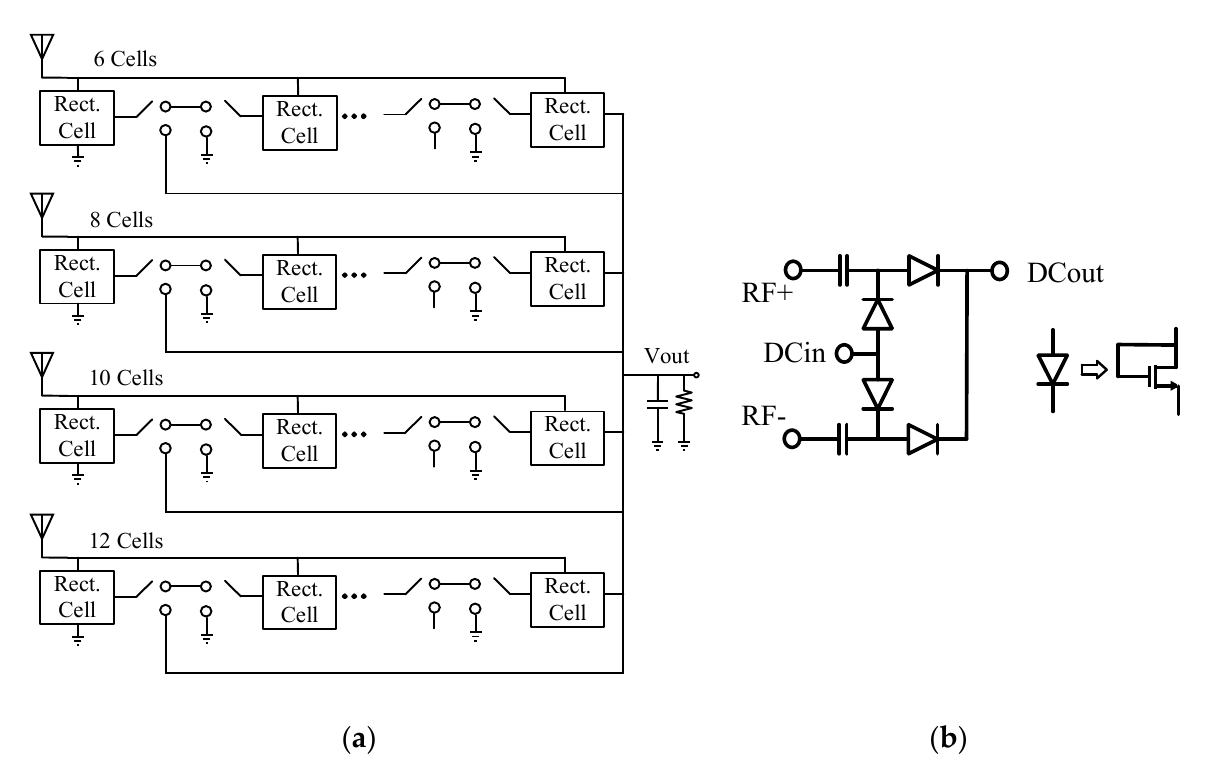
Figure 3. ( a ) A 4-input reconfigurable rectifier array and ( b ) single rectifier cell.